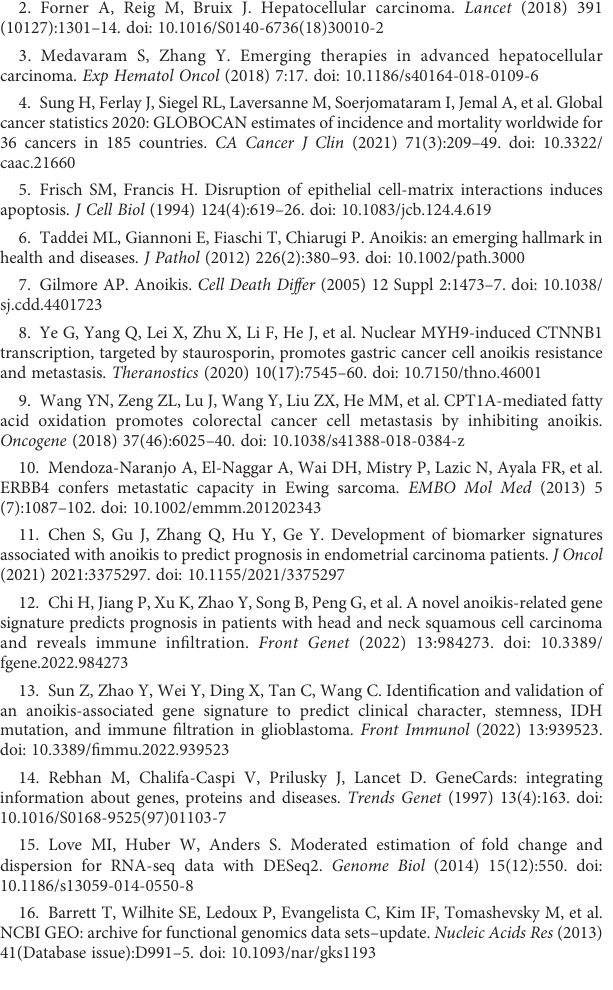
SUPPLEMENTARY FIGURE 4 Survival analysis of 10 hub genes from 229 DEGs. (A – L) Kaplan – Meier curves of 6 hub genes in TCGA cohort (A – F) , ICGC cohort (G – L) . (M, N) Multivariate Cox regression analysis was carried out for the OS of 6 hub genes in TCGA cohort (M) and ICGC cohort (N) . SUPPLEMENTARY FIGURE 5 Evaluation of chemosensitivity and the mutation level of hub genes from 229